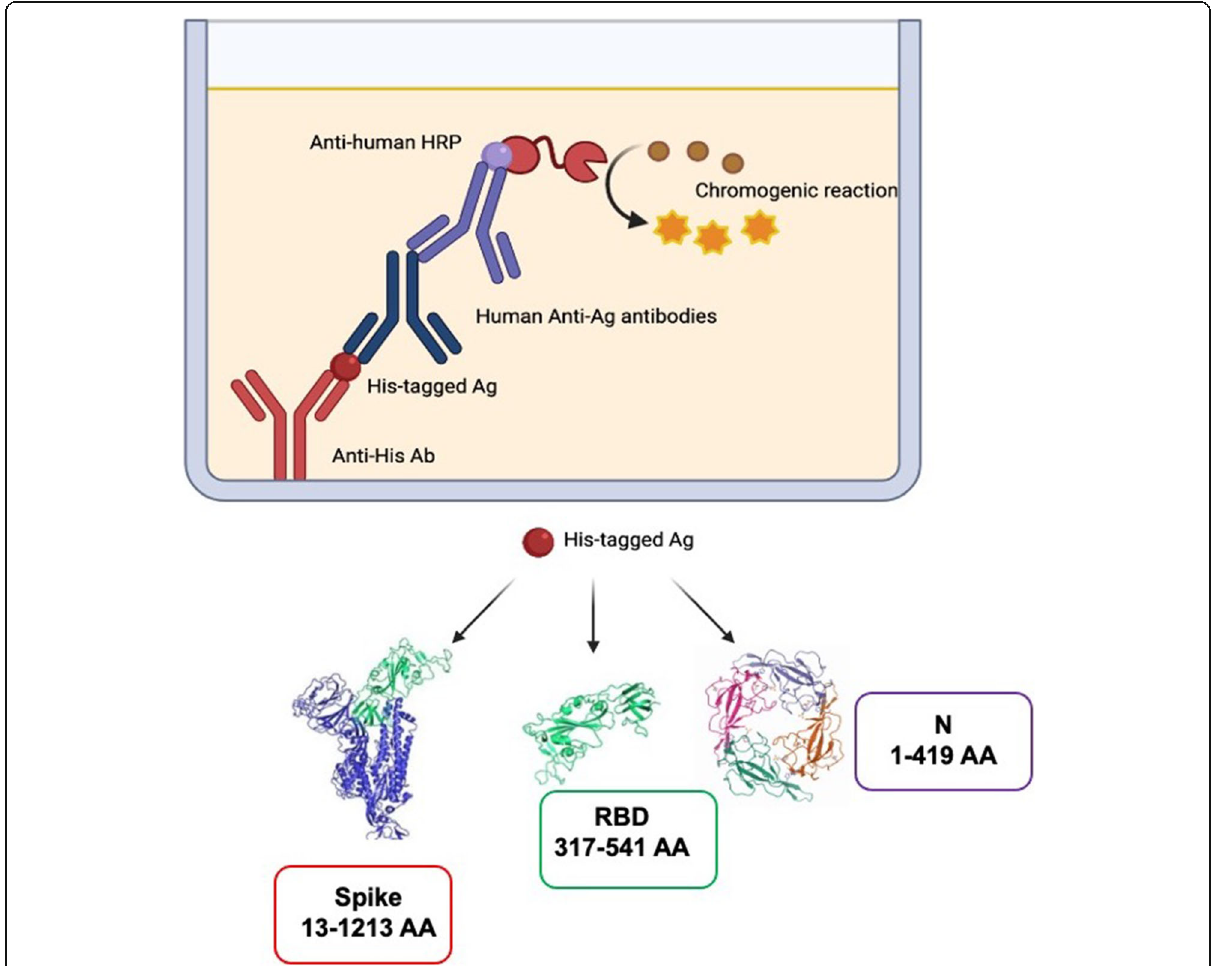
Fig. 1 Serological assays using various His-tagged SARS-CoV-2 antignes. The boundaries of the substrates (S, RBD and N) are indicated by the amino acid numbers from N- and C-termini,